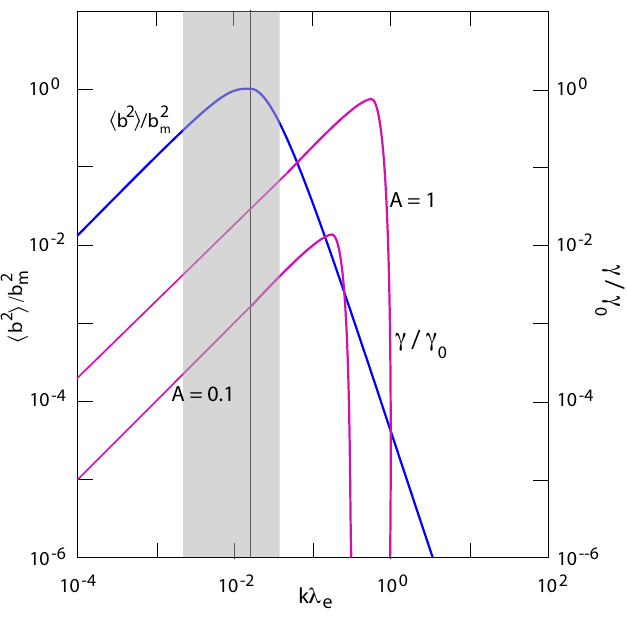
Fig. 2. Wavenumber dependencies of the normalised fluctua- tion spectrum and normalised growth rates. The normalisation of the thermal fluctuation spectrum is to its maximum value given in Eq. (13). Normalisation of the growth rate is to γ 0 = √ ω e π/ 2 (c/v e ) . Since the growth rate depends on anisotropy A it is given for the two cases A = 0 . 1 , 1. Note the competition between growth rate and fluctuation level. At long wavelengths the high fluctuation level partially compensates for the low growth rate. The range of wavelength of interest in the magnetospheric tail is shown shaded. It centres around maximum thermal fluctuation level.